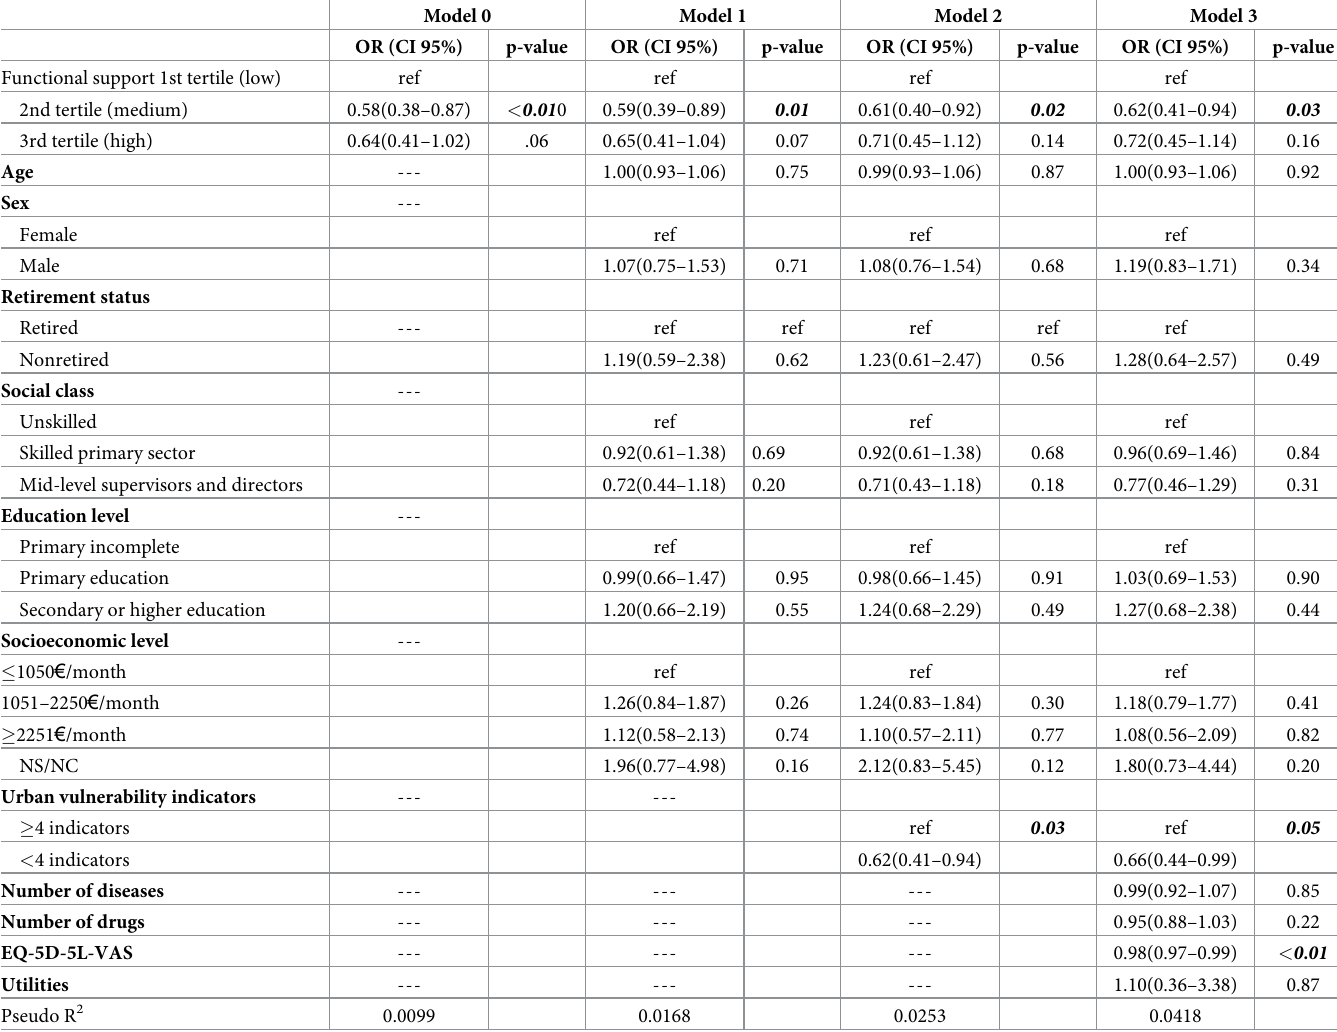
Table 3. Factors associated with nonadherence to treatment in patients with multimorbidity and polypharmacy.